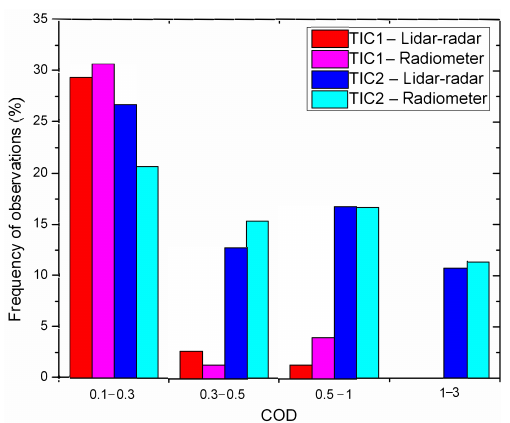
Figure 8. Histogram of active and passive classifications of TIC (TIC1 in red and pink; TIC2 in blue and cyan) as a function of COD.